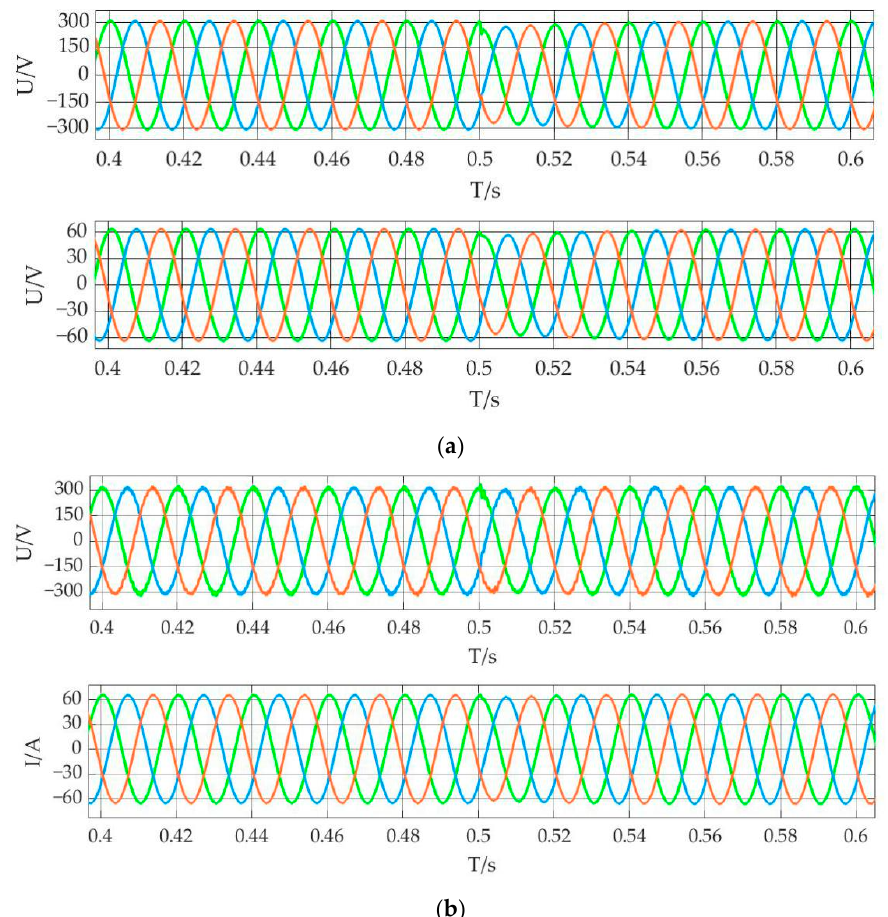
Figure 9. Voltage and current diagram of the first type of islanding critical load. ( a ) With v/F control. ( b ) With electric spring control.